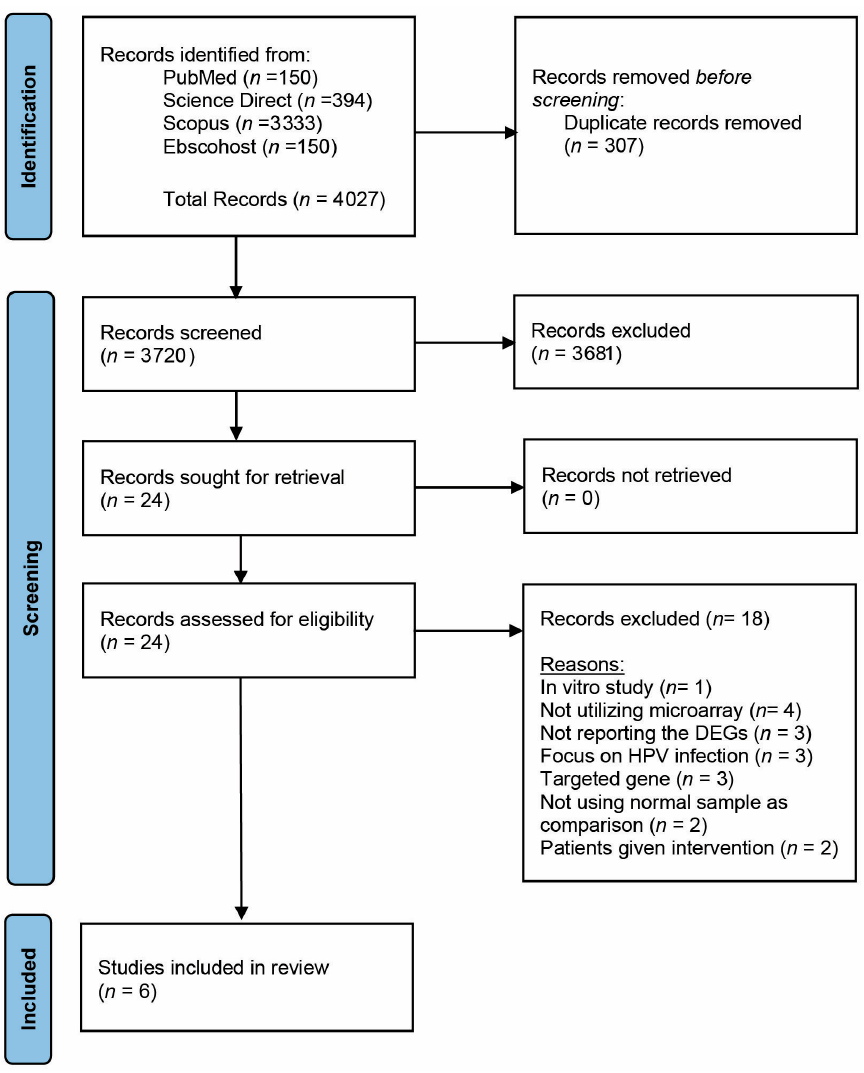
Figure 1. PRISMA flow diagram for studies’ selection in this systematic